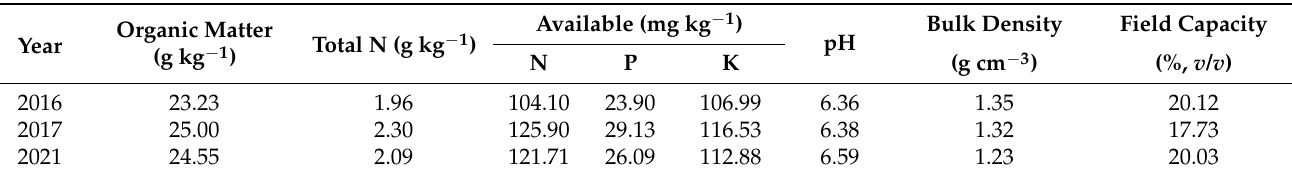
Table 1. Average values for selected soil characteristics of composite topsoil samples (0–20 cm) from the experimental fields in 2016, 2017, and